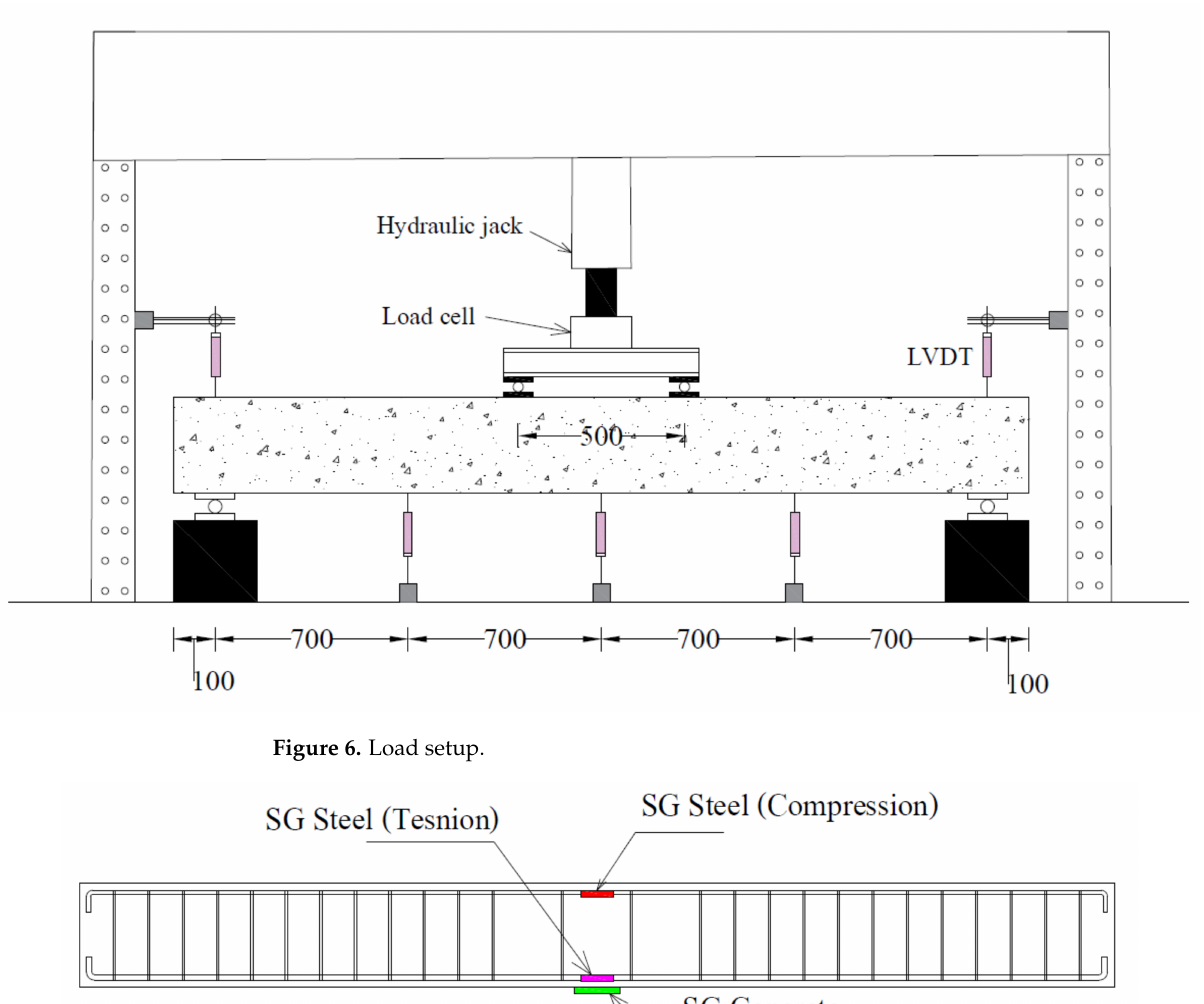
Figure 7. Position of strain